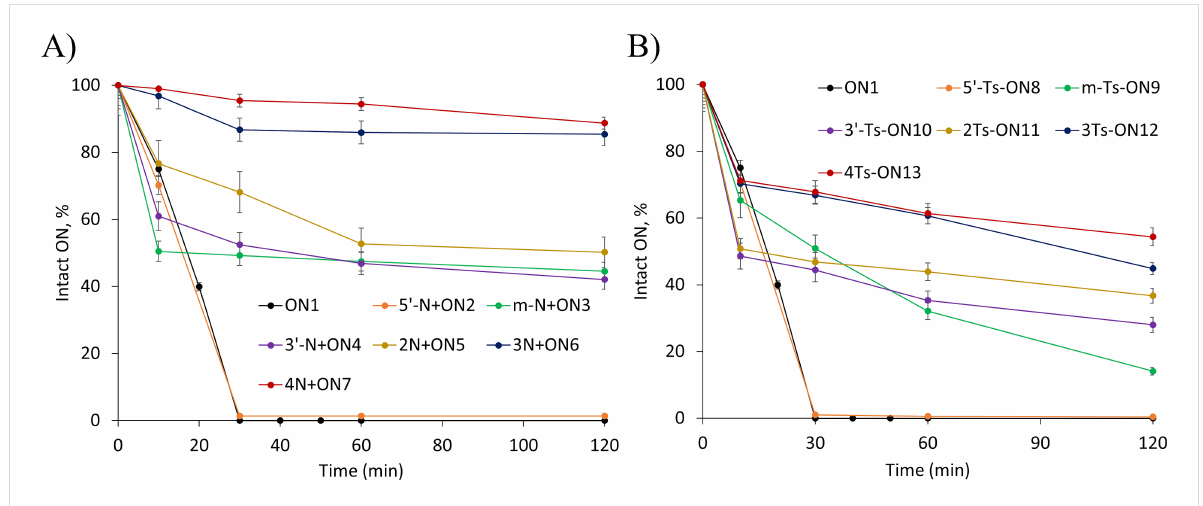
Figure 2: Percentage of intact ONs after 120 min. A) N+ONs; B) Ts-ONs. Percentage of intact ONs was determined by the ratio of full-length ONs at individual time in comparison with the sample at 0